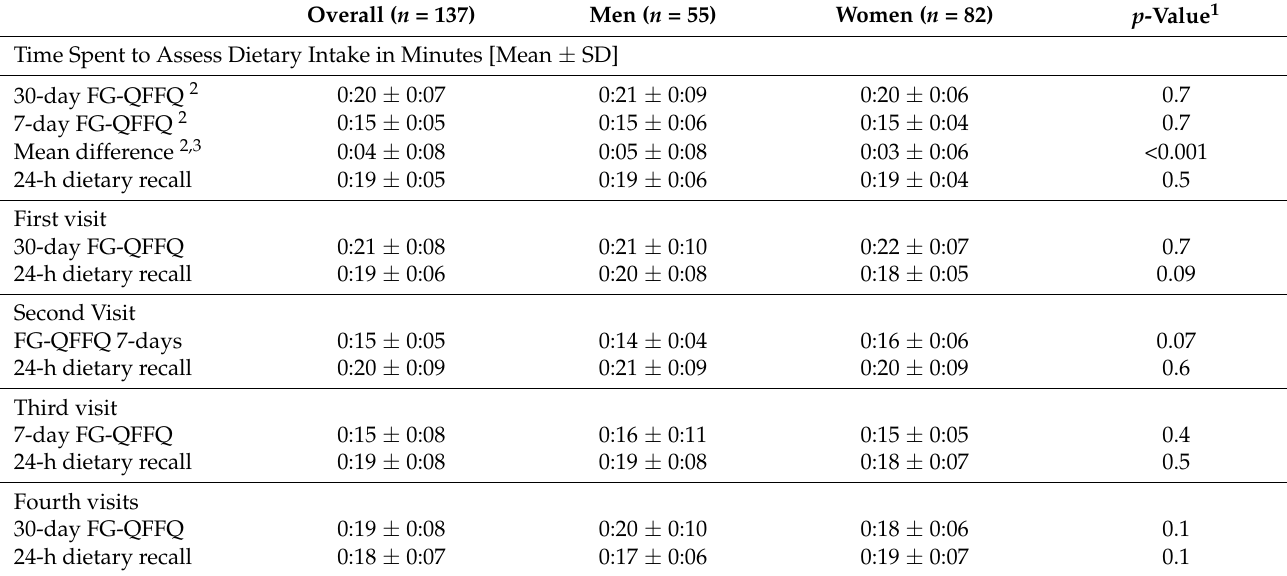
Table 2. Average time spent in the dietary assessment procedures for the 30-day FG-QFFQ, the 7-day FG-QFFQ, and the 24-h dietary